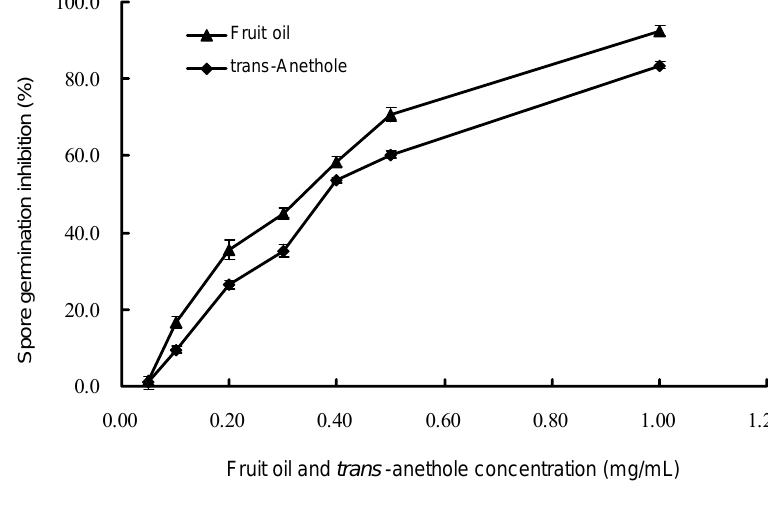
Figure 3. Inhibitory effect of I. verum fruit oil and trans -anethole on the spore germination of M. oryzae